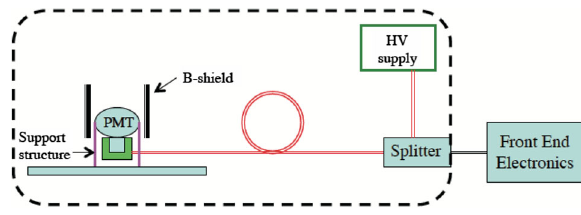
Fig. 11 Schematic of Inner PMT system